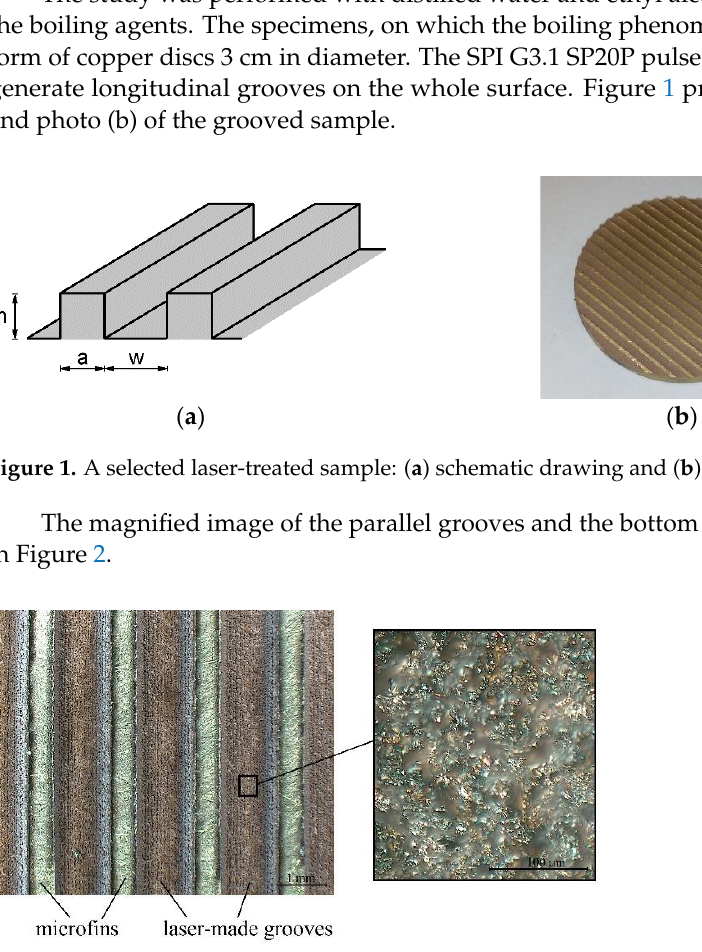
Figure 2. The surface morphology details (mag. 35×, left-hand side picture), with the bottom microstructure (mag. 700×, right-hand side picture).